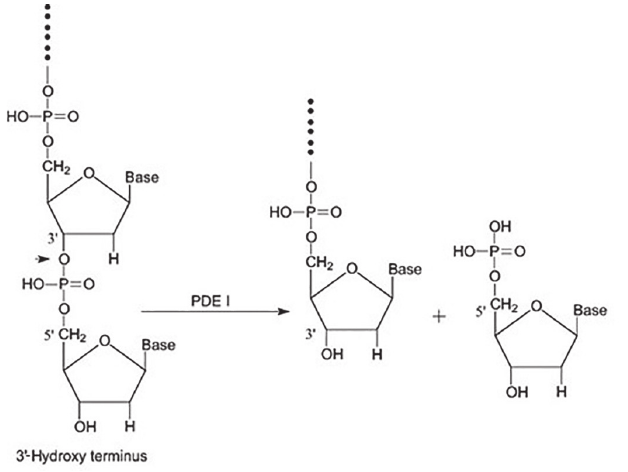
FIGURE 1 - PDE catalyzes the cleavage in the 3′- to 5′-direction to yield nucleoside 5′-phosphates.